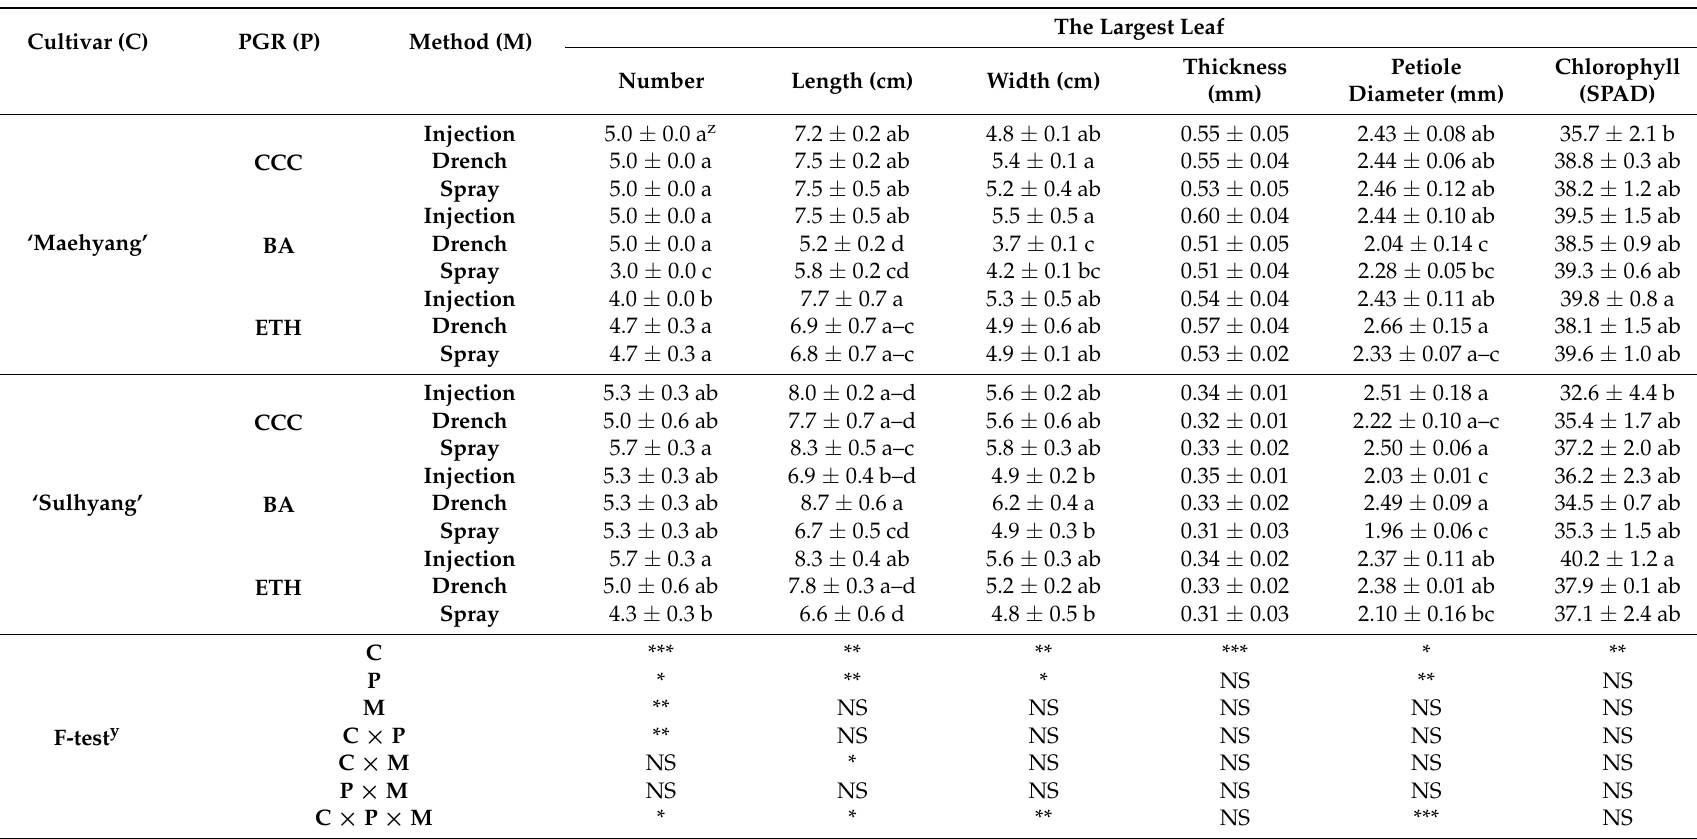
Table 3. Effect of PGR and application method on growth and development of runner plants of strawberries ‘Maehyang’ and ‘Sulhyang’ grown for 30 days. Cultivar (C)